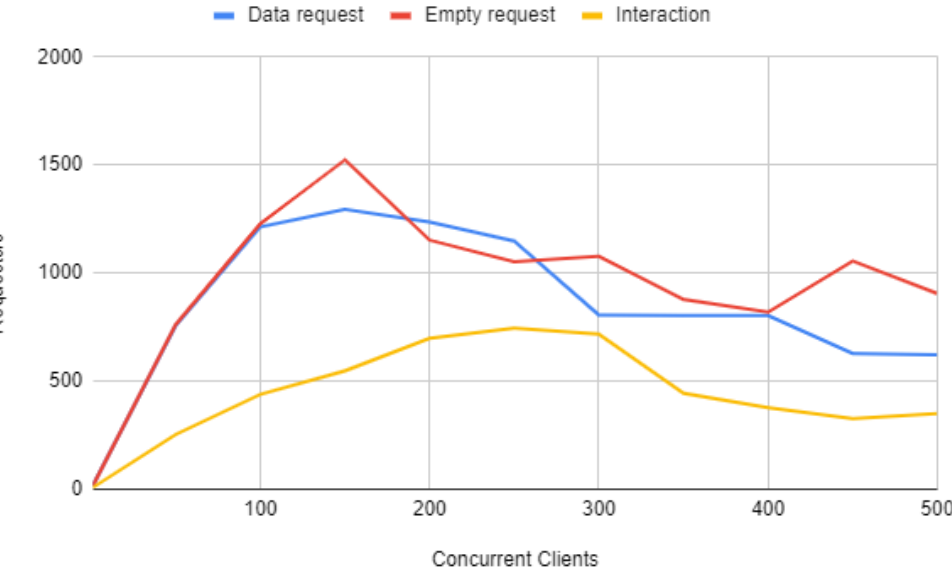
Figure 14. Throughput of the framework when increasing the load of the